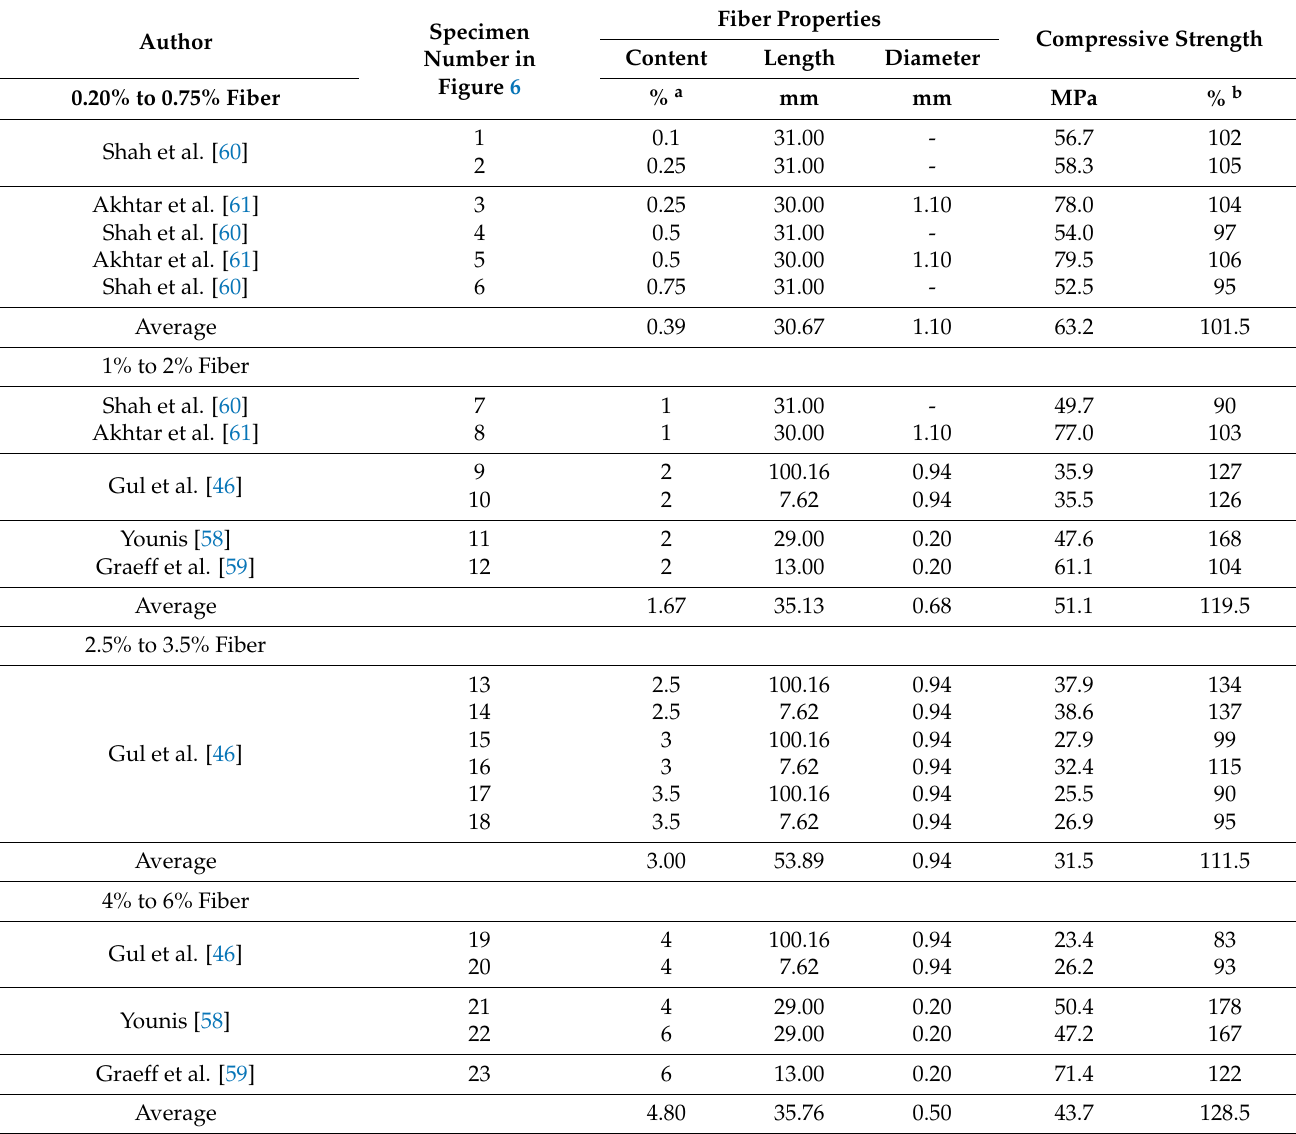
Table 4. Results of compressive strength’s percent comparison and fiber properties of the concrete with RSF by its